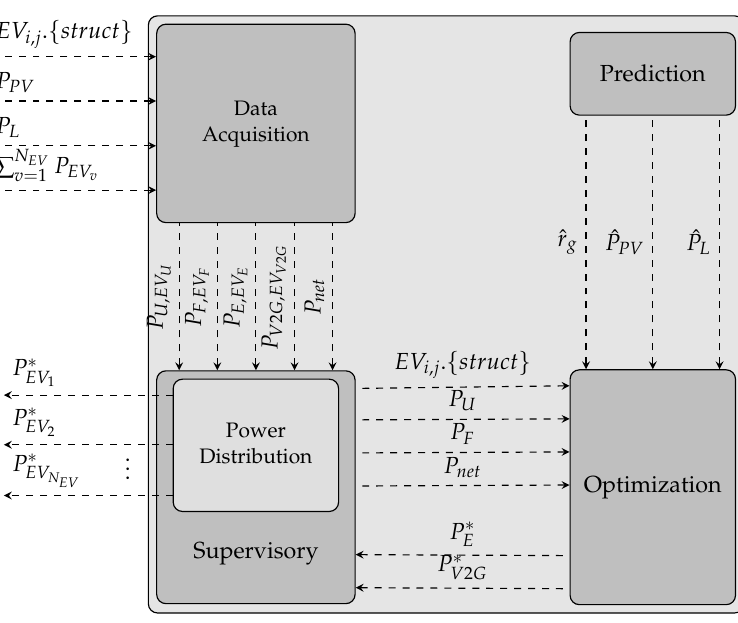
Figure 4. Proposed manager